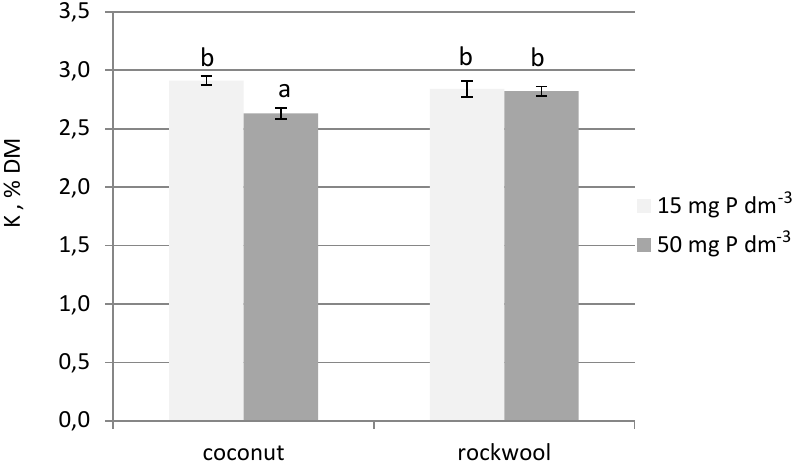
Fig. 5. Interaction between phosphorus level in nutrient solution and type of substrate on K content in tomato leaves. Means followed by the same letters are not significantly different at p < 0.05; bars indicate standard error. AMF-/AMF+ – non-inoculated plants by